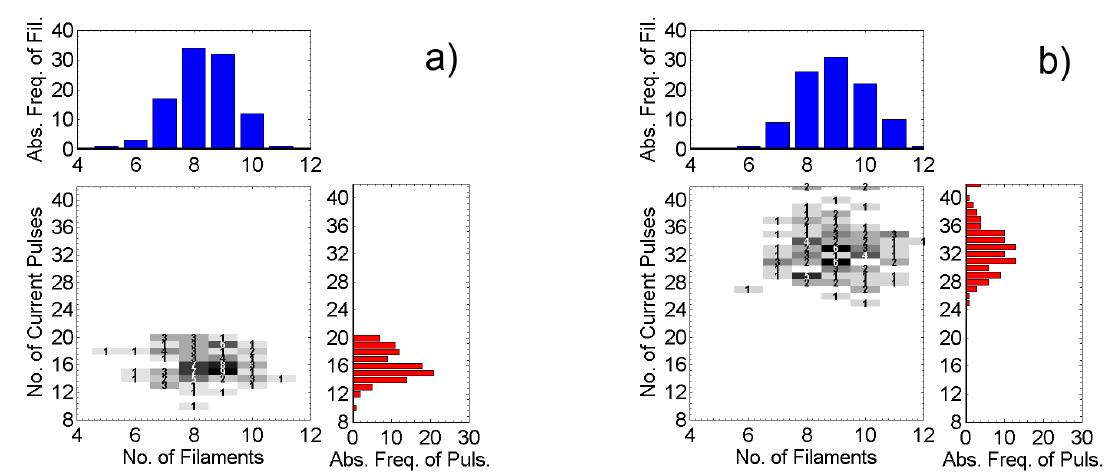
Figure 12 : Relation matrix of incidence, DCSBD at voltage amplitude 18 kV and electrode gap 2.0 mm; a) positive half-period, b) whole period of